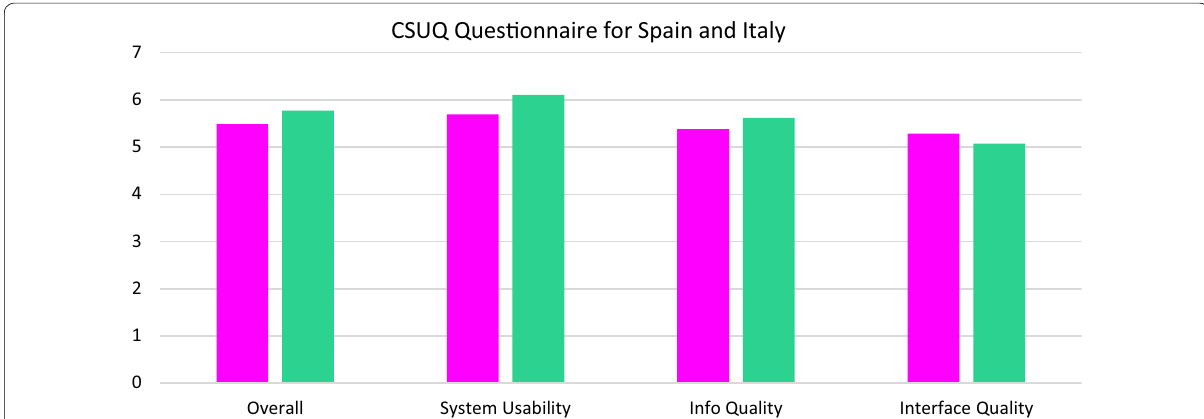
Fig. 4 The Pulso system. The Trilogis‑Monsenso. The Pulso wristband system. The Trilogis‑Monsenso wristband system. Patient‑based evaluation measured using the USE questionnaire of the smartphone‑based systems the Trilogis‑Monsenso system and the PULSO system and the two